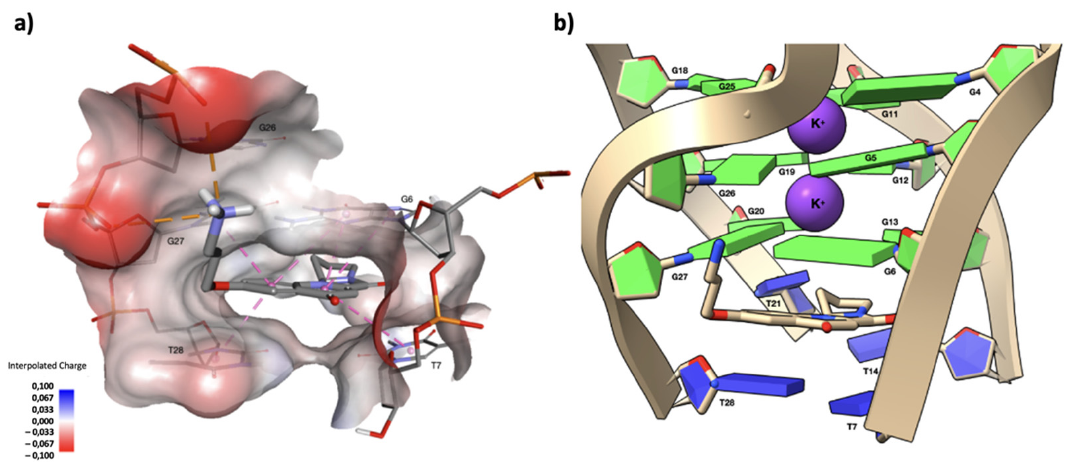
Figure 6. ( a ) Drawing that shows the first interaction shell of compound 9 complexed with the d(TTAGGGT) 4 G-quadruplex, as obtained from the molecular docking experiment. In this position, compound 9 is capable of forming multiple π – π stacking interactions between the aromatic rings of the polycycle and those of the G6 and T7 units. The side chain of compound 9 orients along the groove, with the quaternary nitrogen forming two salt bridges with G5OP 2 and G6OP 2 , contributing to the stabilization of the complex. In the figure, G5, G6 and T7 are labelled as G26, G27 and T28, respectively, due to the loss of symmetry in the complex. The non-bonded interactions are displayed as dashed lines, the π – π stacking interactions in pink, and the two salt bridge interactions in orange. A surface near the current ligand is created around the target and colored by the interpolated